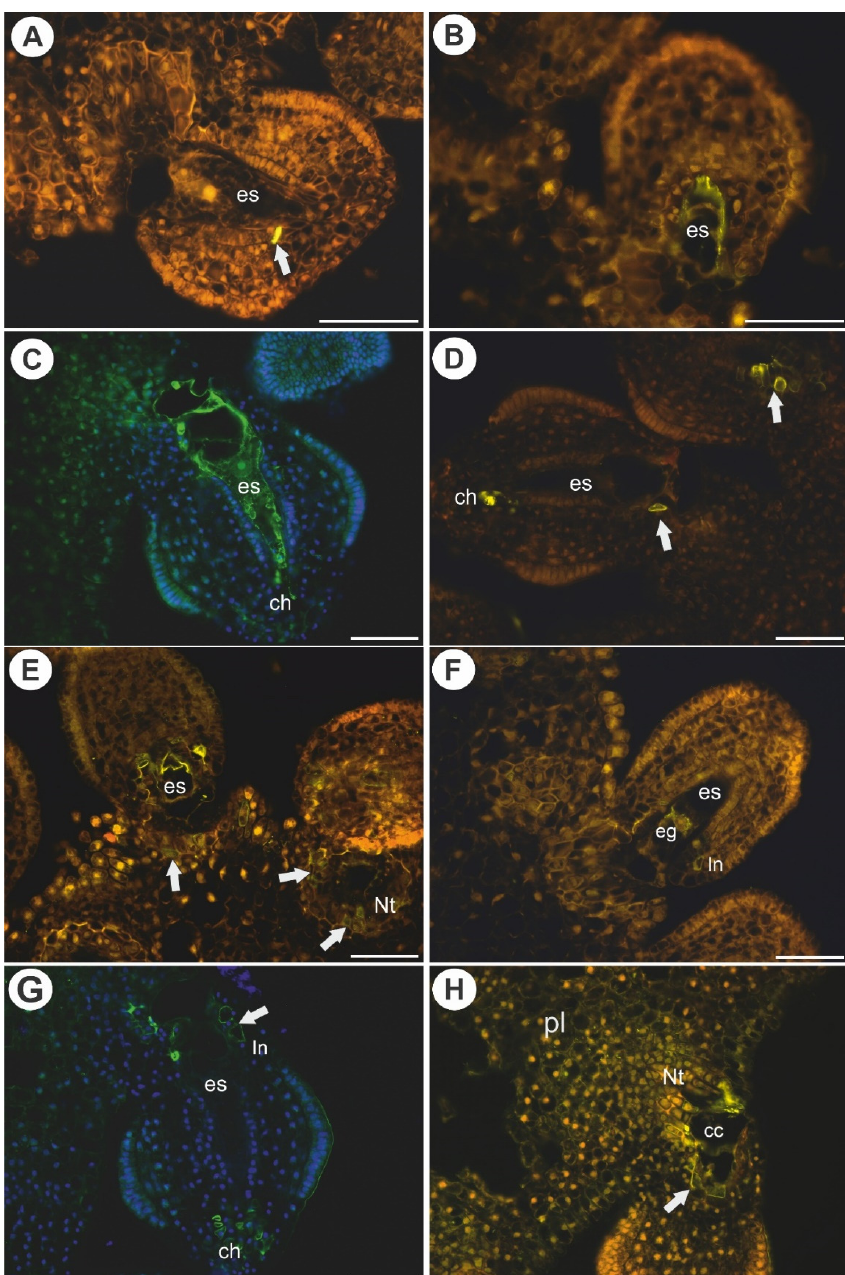
Figure 3. Arabinogalactan proteins (labeled with JIM8 and with JIM14, green fluorescence) detected in Utricularia nelumbifolia and Utricularia humboldtii before pollination. ( A , B ) Arabinogalactan protein (labeled with JIM8, green fluorescence) detected in U. nelumbifolia: embryo sac (es), positive signal in the integument cell (arrow); yellowish signal is autofluorescence. ( C , D ) Arabinogalactan protein (labeled with JIM8, green fluorescence) detected in U. humboldtii , embryo sac (es), chalaza (ch), note the positive signal in the integument cells (arrow); yellowish signal is autofluorescence. ( E , F ) Arabinogalactan protein (labeled with JIM14, green fluorescence) detected in U. nelumbifolia : embryo sac (es), positive signal in placenta nutritive tissue (Nt) cell (arrow), egg cell (eg), integument (In); yellowish signal is autofluorescence. ( G , H ) Arabinogalactan protein (labeled with JIM14, green fluorescence) detected in U. humboldtii; embryo sac (es), placenta (pl), nutritive tissue (Nt), integument (In), chalaza (ch), positive signal in the integument cells (arrow); yellowish signal is autofluorescence. All bars 50 µ